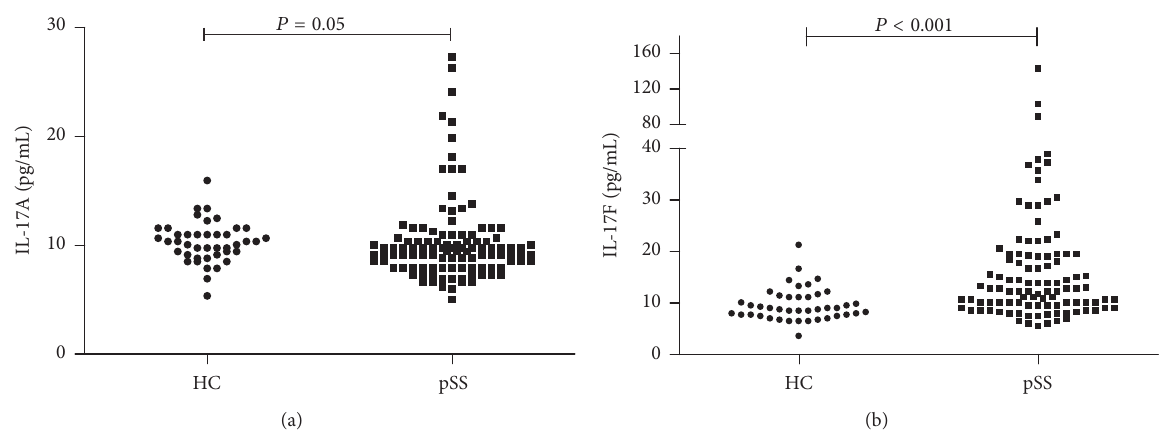
∗ 1 patient did not have the data of C3 and C4. ∗∗ 4 patients did not have the data of ANA.